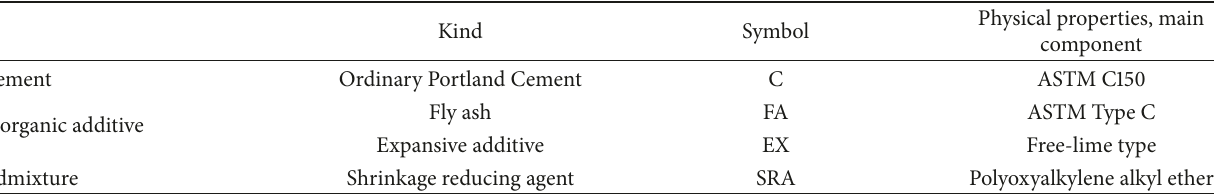
Table 1: Materials.